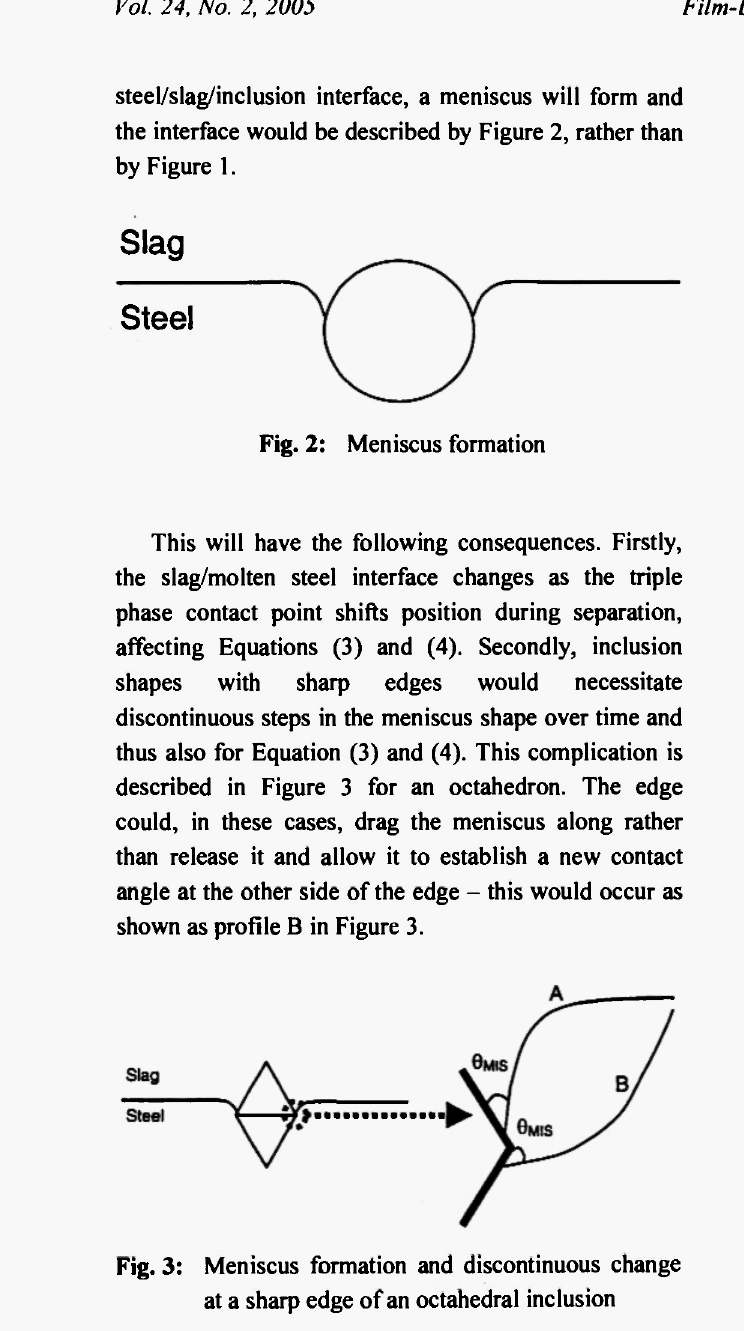
Meniscus formation and discontinuous change